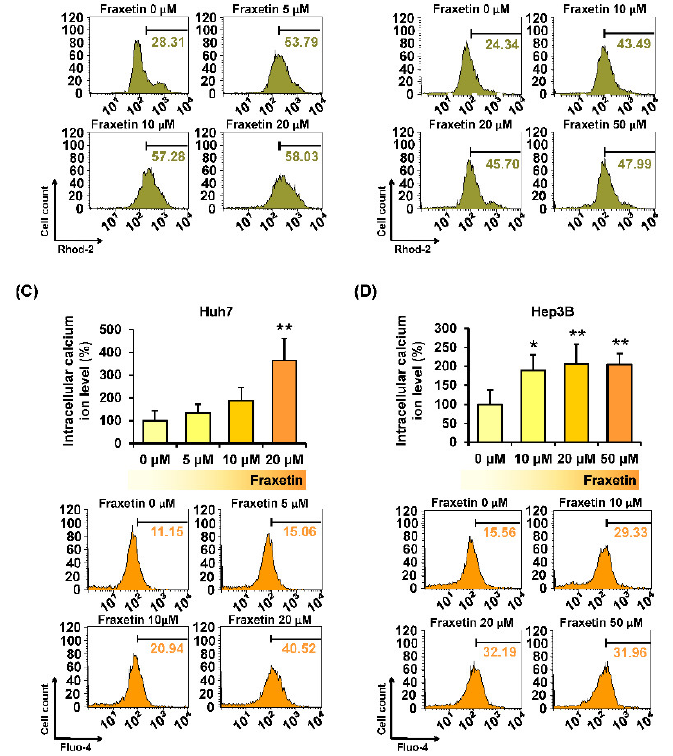
Figure 5. Effects of fraxetin on calcium homeostasis in the mitochondrial matrix and cytoplasm of Huh7 and Hep3B cells. ( A , B ) Accumulation of calcium in the mitochondrial matrix. The right part of the peaks were measured and represented as a percentage-ratio in the bar graphs. ( C , D ) Intracellular calcium concentrations. Asterisks indicate the significance levels of comparisons between vehicle- and fraxetin-treated cells (* p < 0.05, ** p < 0.01, and *** p < 0.001).